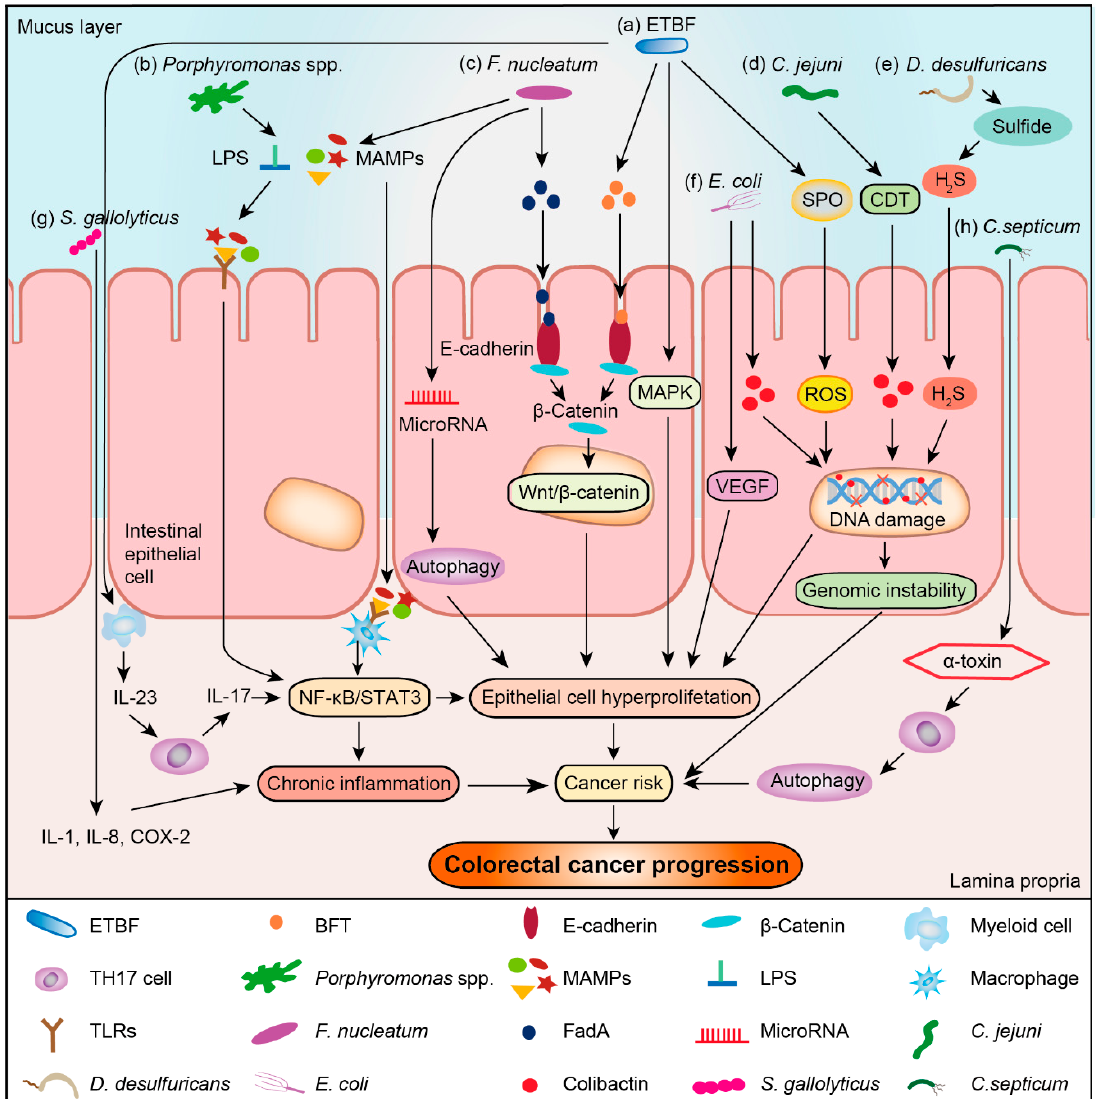
Figure 1. Bacteria-associated mechanisms involved in the development and progression of CRC. ( a ) Enterotoxigenic B. fragilis (ETBF) secretes B. fragilis toxin (BFT) to interact with the E-cadherin and β -